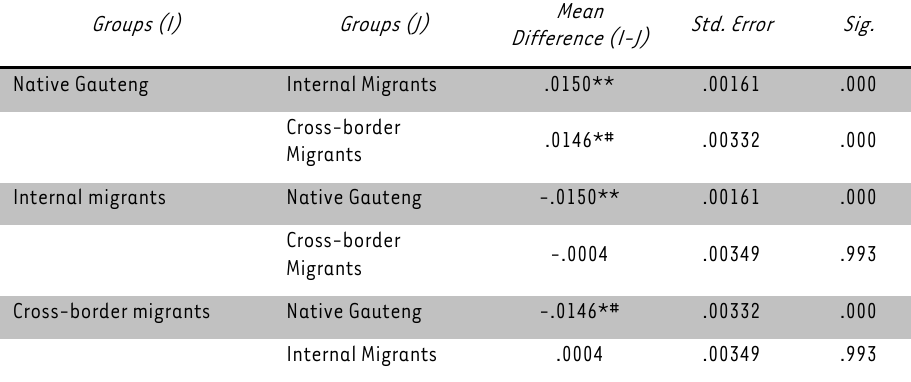
One-way ANOVA comparing the means of the groups Sum of Squares df* Mean Square F Sig. Between groups 0.550 2 0.275 48.553 0.000 64.957